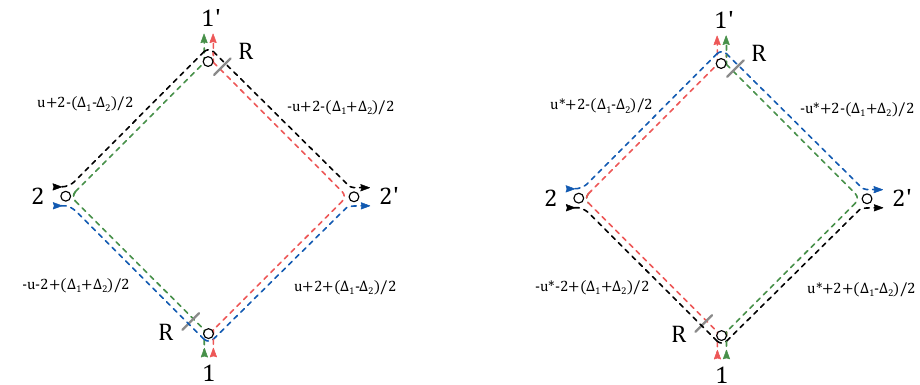
Figure 12 . Left: diagrammatic representation of the kernel R 12 ( x 1 , x 2 | x 0 R 12 ( u ) . It is obtained from the kernel of figure 11 (left) by exchange of the points 1 and 2 following ˆ from the definition R = P R 12 . Right: diagrammatic representation of the kernel of the operator 12 12 ( u ) . The color of lines — that is the values of the spins — get exchanged by the hermitean R † 12